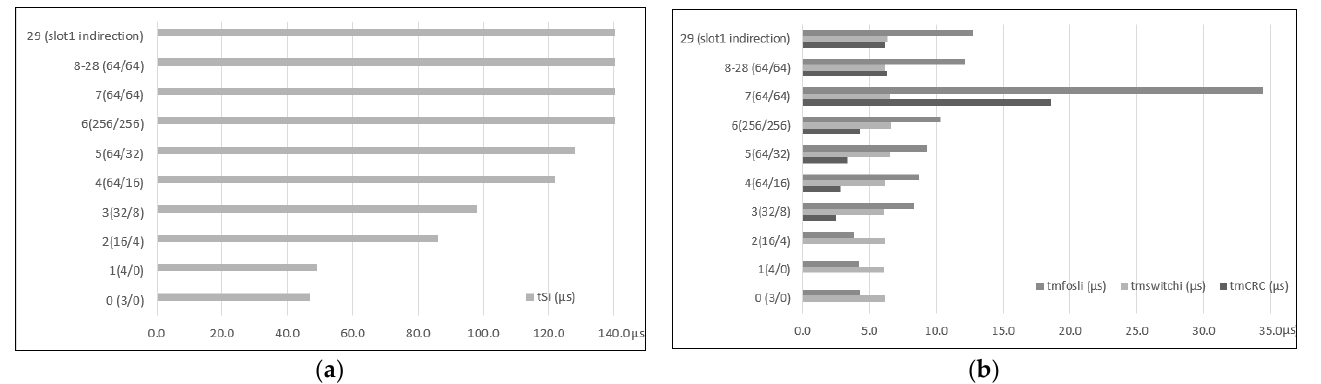
Figure 8. Measured times for acquisition cycle slots at client: ( a ) periods for tSi corresponding to ModbusE acquisition slot; ( b ) jitter for tmfosli, tmswitch, and tmCRC times with ModbusE extension.